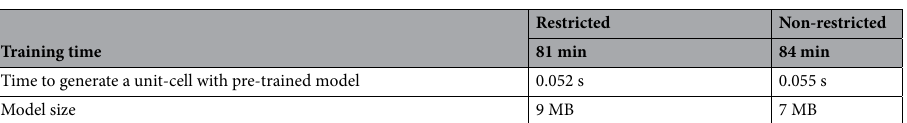
Table 4. Information of training time, time to generate a unit-cell, and the model size for both restricted and non-restricted structures.